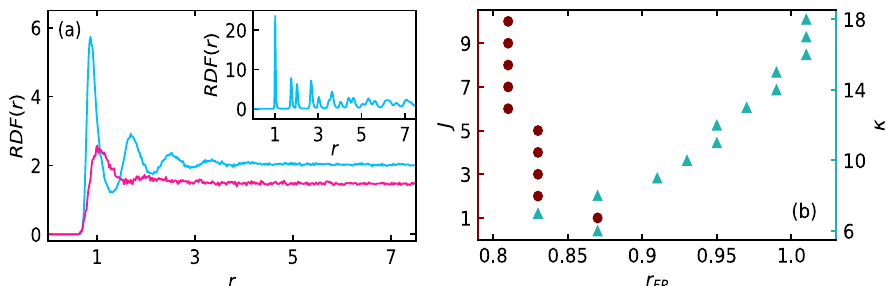
Figure 4. ( a ) Radial distribution function RDF( r ) in high (blue) and low (red) density phase for the soft disks at 125 . Inset shows the RDF for hard disks at κ 6 for M 0.05 , J 18 . ( b ) Radial location of 2 , and P κ e = = = = = 7 and with variation in the first RDF peak r FP with variation in J (left vertical axis) (circles) for fixed softness κ = 125 0.05 and P 2 , at constant M κ (right vertical axis) (triangles) for fixed J e = = =